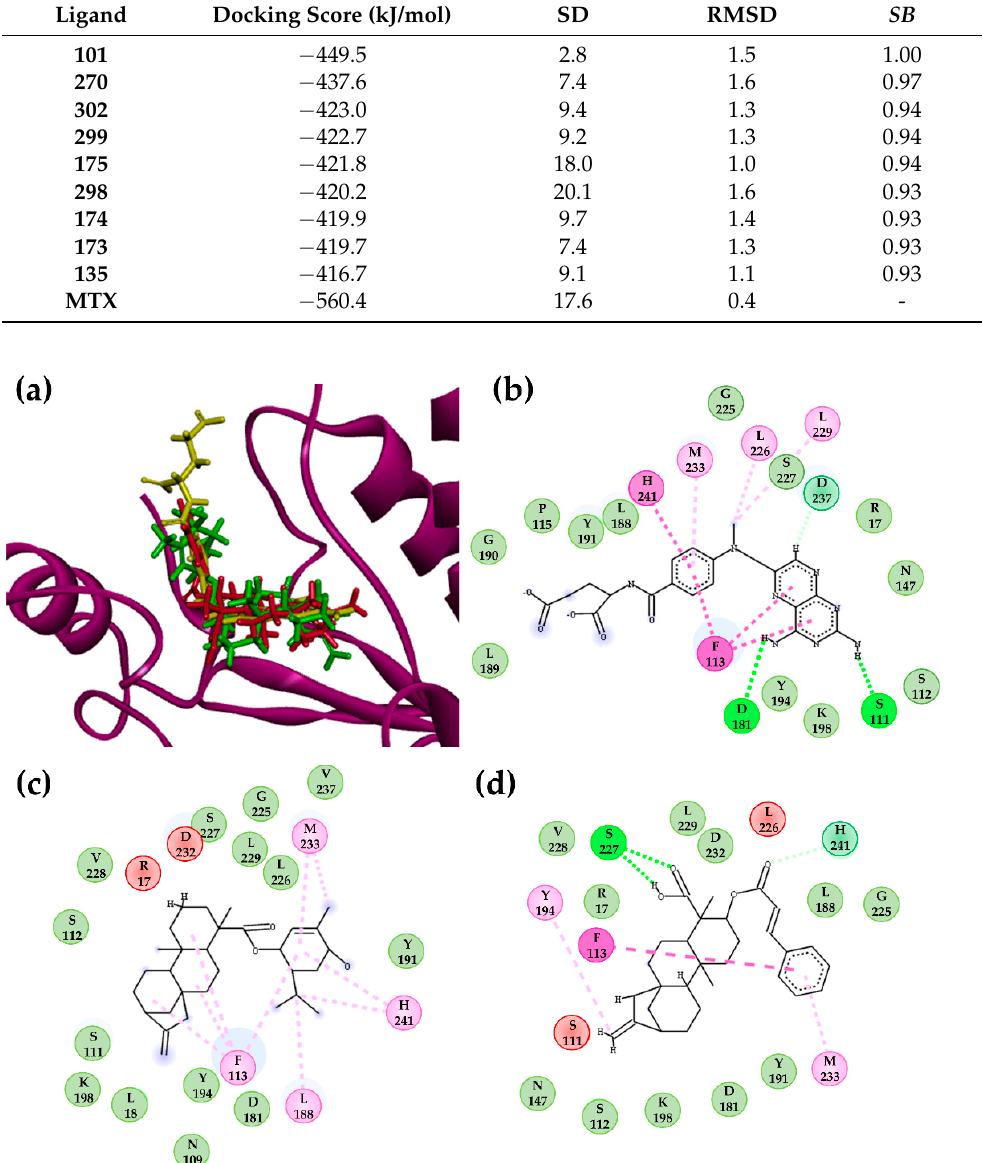
Table 1. Docking energies of the best-ranked structures from the structure-based VS for L. major PTR1. SD = standard deviation; RMSD values = root mean square deviation; and SB = structure- based probability.